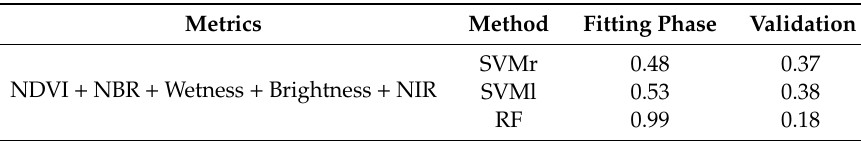
Table 9. Fuel type classification using Sentinel-2